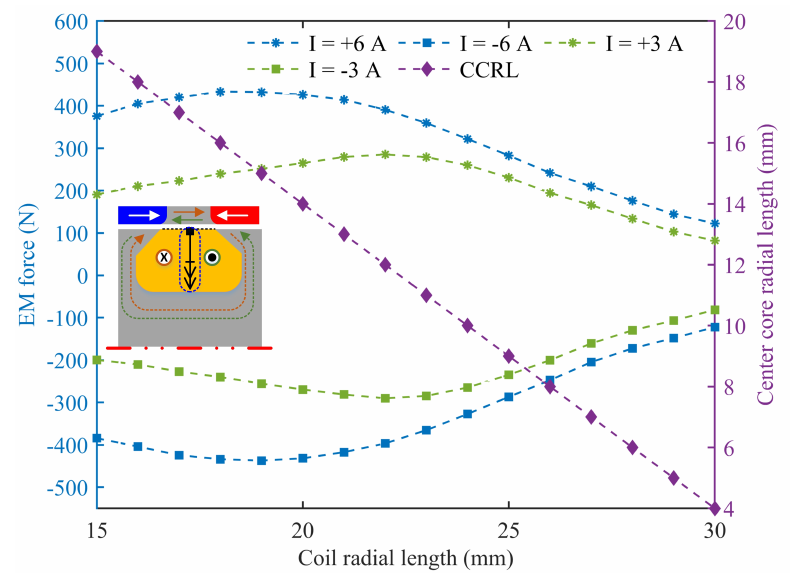
Figure 6. Coil and core radial length optimization.